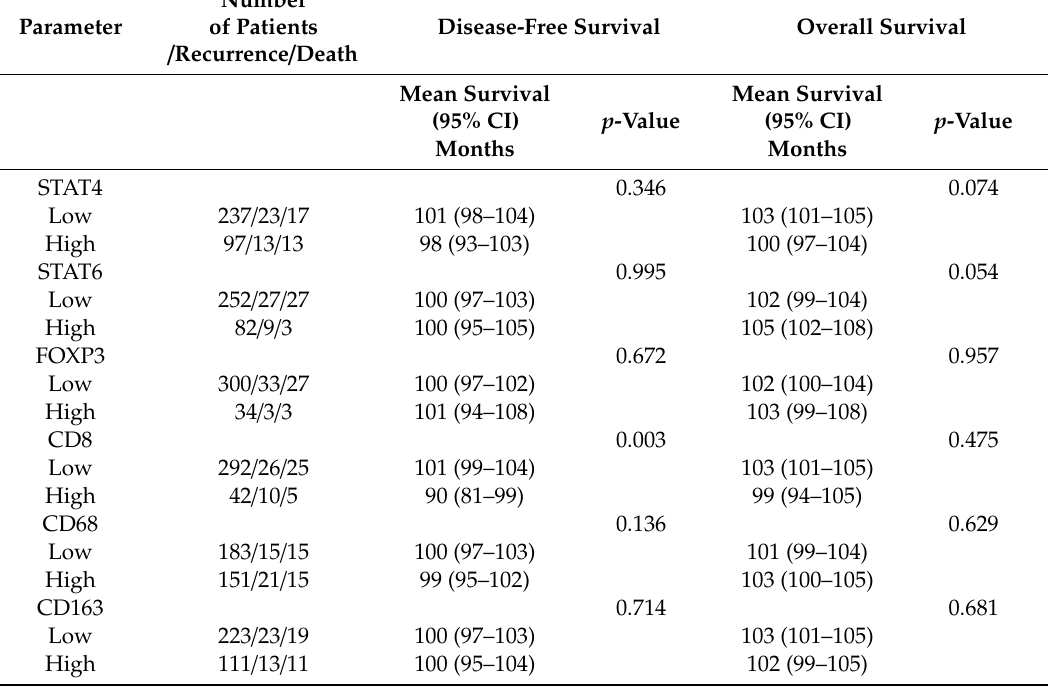
Figure 2. The relationship between clinicopathologic parameters and immune cell subtype-related protein expression. A higher histologic grade was associated with high expression levels of STAT6, FOXP3, CD68, and CD163; ER negativity was associated with high STAT6, FOXP3, and CD163 expression levels, whereas PR negativity and high Ki-67 L.I. were associated with high CD163 expression. HG: histologic grade; L.I.: labeling index. Table 5. Univariate analysis of the impact of infiltrating immune cell subtype-related protein expression in breast cancers on disease-free survival and overall survival using the log-rank Table 4. Correlations between the proportions (%) of ER, PR, and stromal TIL expression levels and immune cell subtype-related protein expression levels.